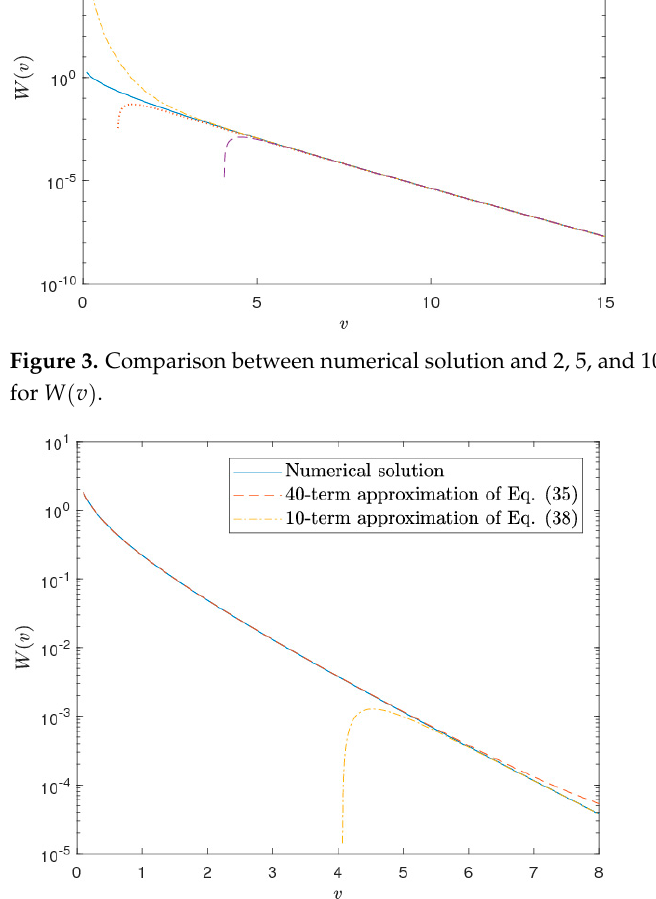
Figure 4. Comparison between numerical solution, 40 terms of the series Equation (35), and 10 terms of the series Equation (38) for W ( v ) .